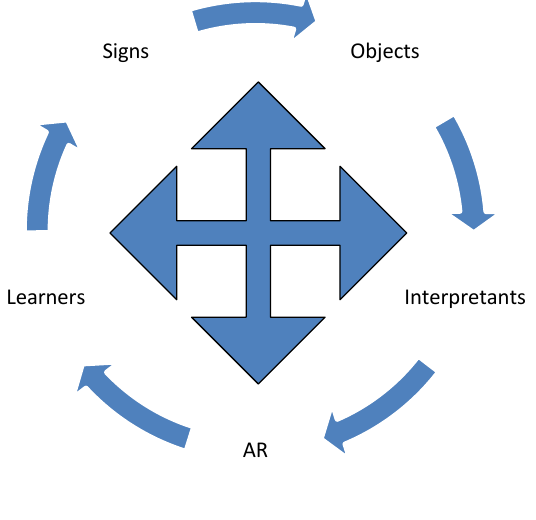
Figure 1: Dialogic Semiosis